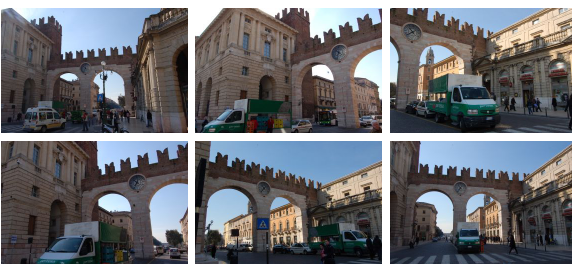
Figure 2: An example of one image (top left) from “Piazza Bra” and its five closest neighbors according to the affinity defined in Eq.